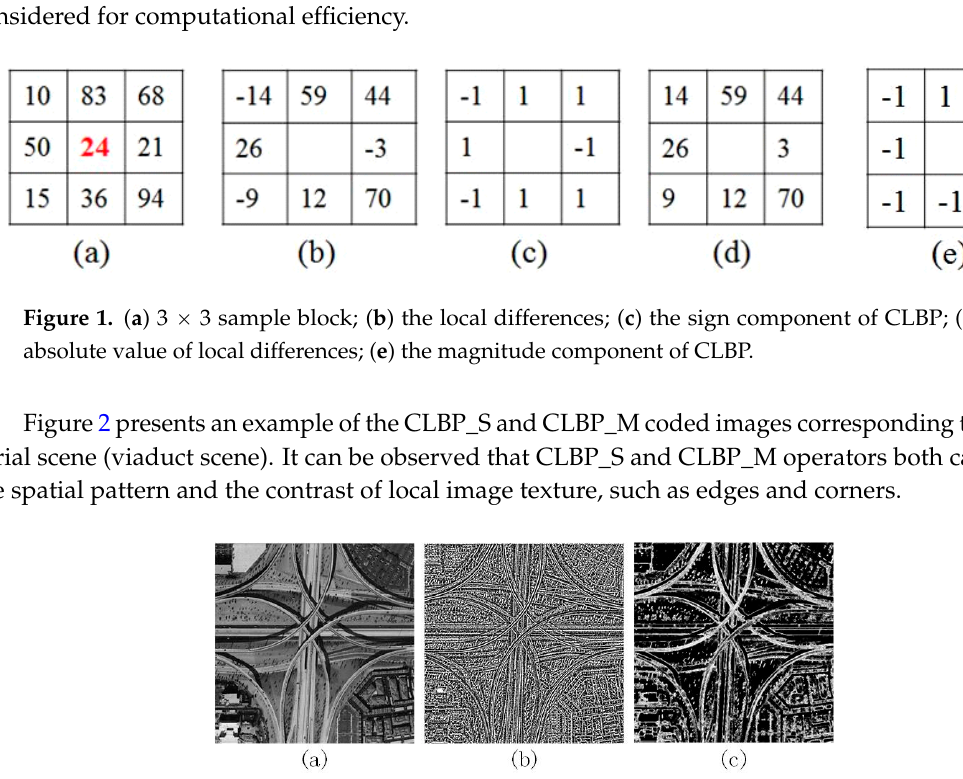
Figure 2. ( a ) Input image; ( b ) CLBP_S coded image; ( c ) CLBP_M coded image.